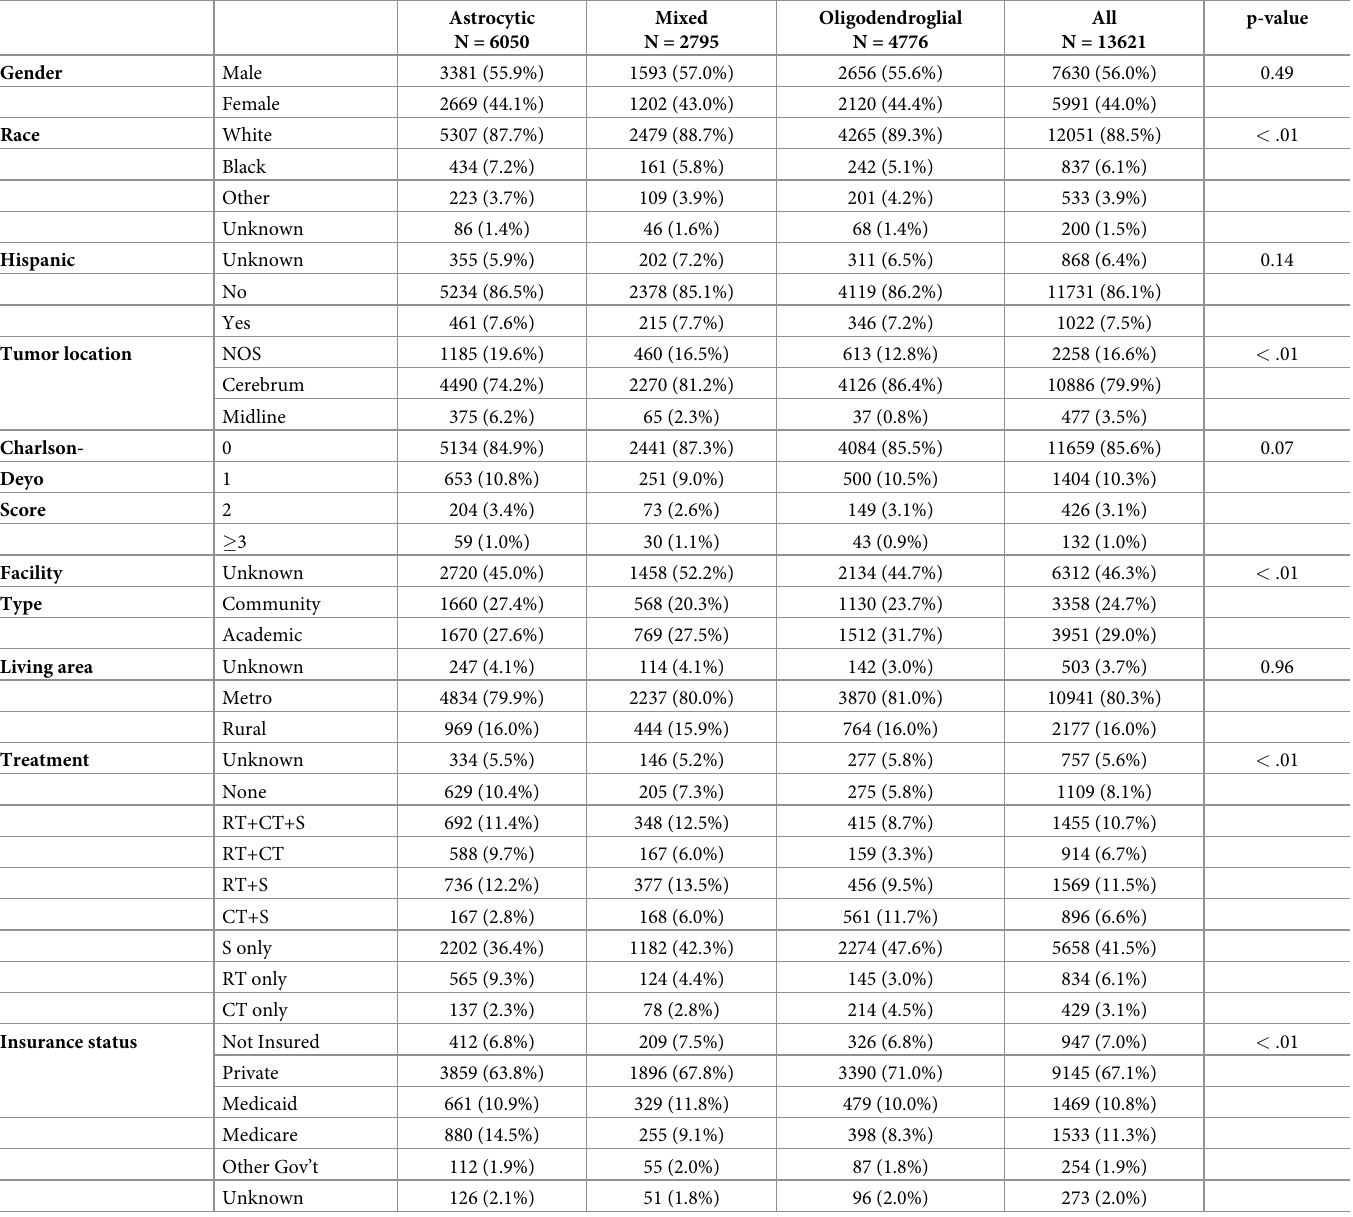
Table 2. Characteristics of the study population, by histology